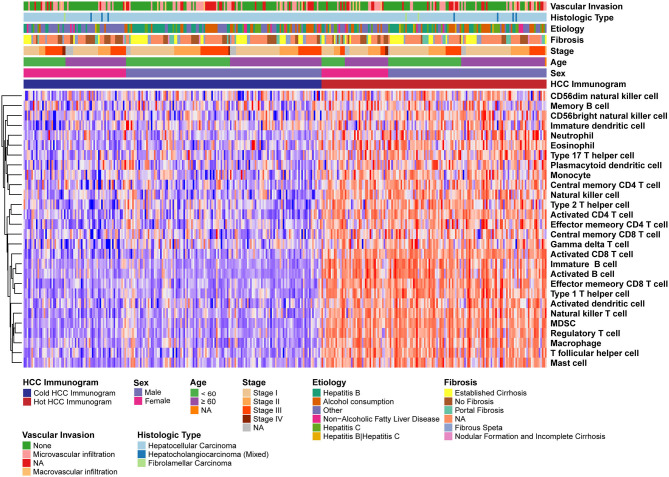
The heatmap of immune cell subsets that infiltrated the tumors of patients in the hot and cold HCC immunogram groups. The relative abundance of 28 immune cell subsets that infiltrated the tumor was evaluated with the sample level gene set enrichment method (GSVA) from the tumor RNA-Seq data. The clinical features, including age, sex, stage, fibrosis, etiology, histological type, and vascular invasion, are shown in the patient annotations.